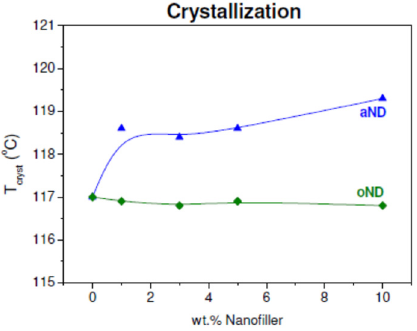
Figure 2. Dependence of the crystallization temperature on the nanofiller content.